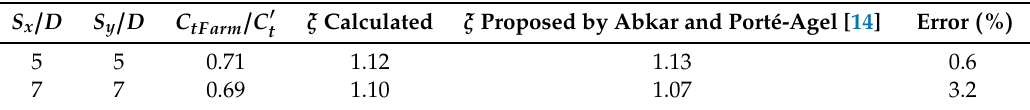
Table 3. Comparison of the results of the ξ parameter (Data from: Abkar and Porté-Agel [14]) with ξ calculated by using our parameterization of C tFarm / C ′ t . ξ Proposed by Abkar and Porté-Agel